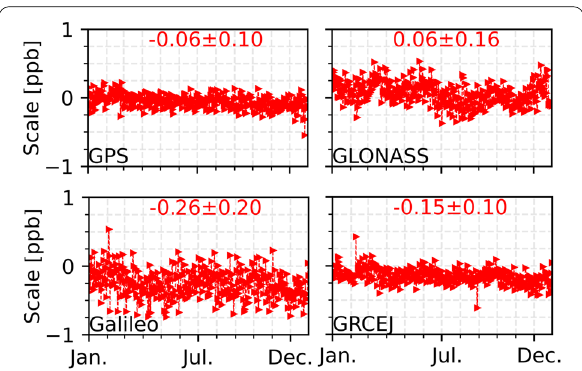
Fig. 11 Scale parameters for single and multi-GNSS PPP solutions with respect to IGS daily coordinates